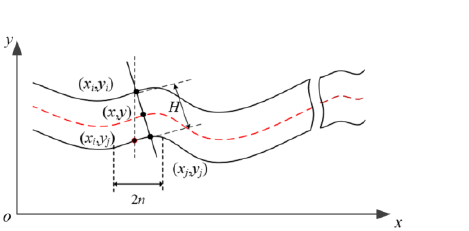
Figure 5. Graphical demonstration of calculating pixel coordinates of the central axis.